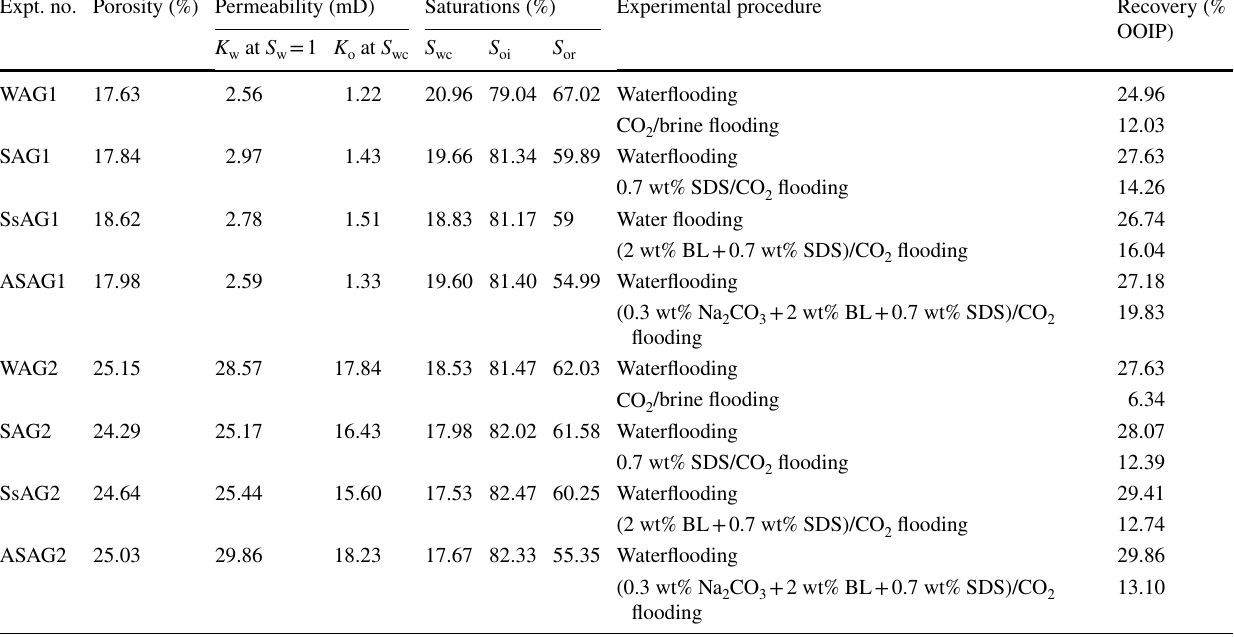
Table 3 Summary of core flooding experiments Expt. no. Porosity (%) Permeability